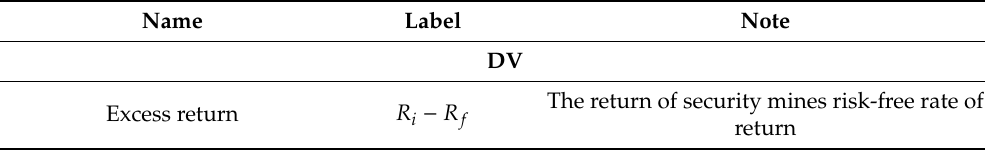
Table 1. Dependent variable and independent